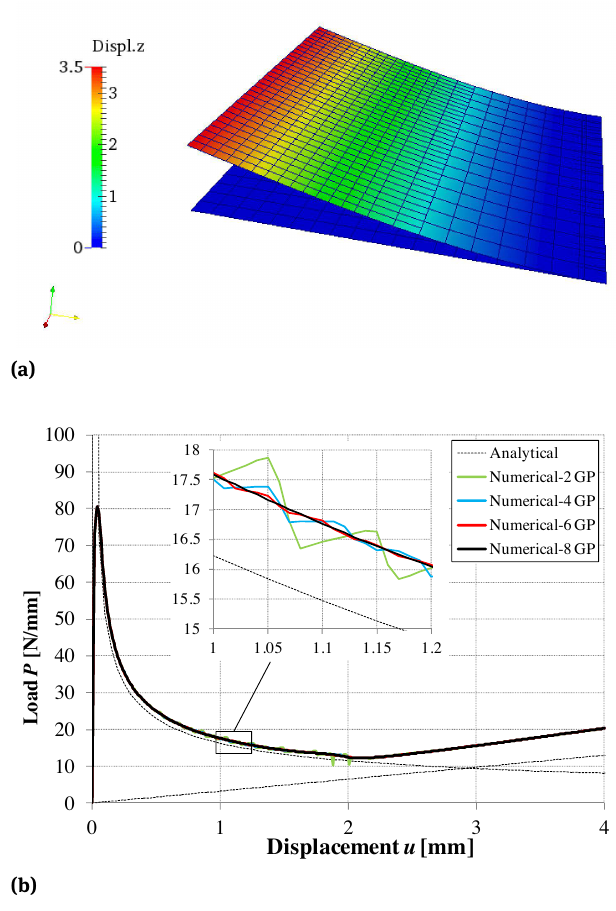
Figure 21: 3D thin-walled quadrangular laminates: (a) displacement contour plot after complete dedonding, and (b) load-displacement global response.